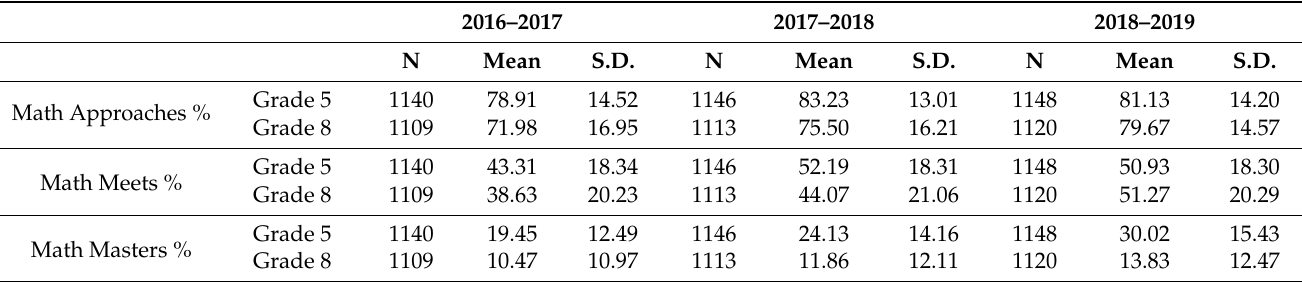
Table 1. Descriptive statistics of school districts’ fifth-grade and eighth-grade STAAR math achievement by performance level for academic years